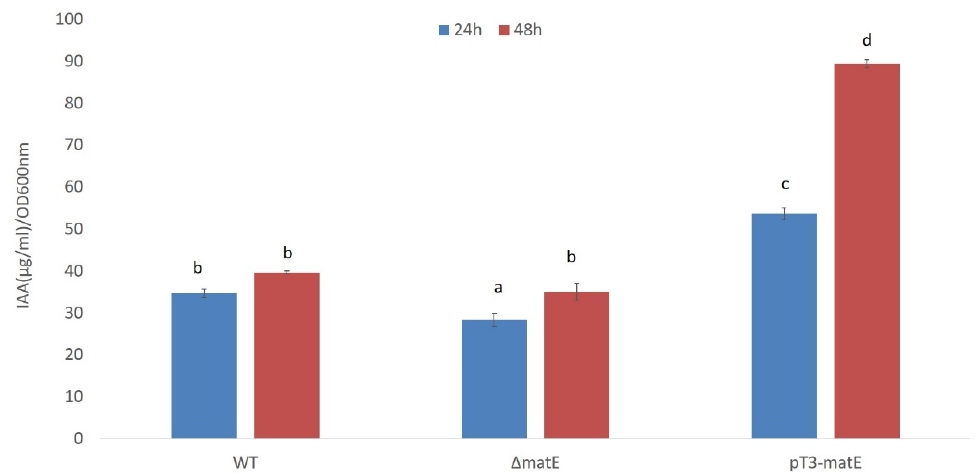
Figure 2. IAA in vitro production by Psn23 and its ∆ matE and pT3- matE mutants. Bacteria were grown on minimal medium (MM) supplemented with L-tryptophan (Trp, 0.25mM), at 26 °C in shaking condition. Salkowski’s assay was carried out on bacterial supernatants collected after 24 h (blue) and 48 h (red) of growth. The data represent the average of three independent experiments, each with replicates ± standard deviation (SD). Di ff erent letters indicate significant di ff erences among means of mutants at p < 0.05, according to Tukey’s